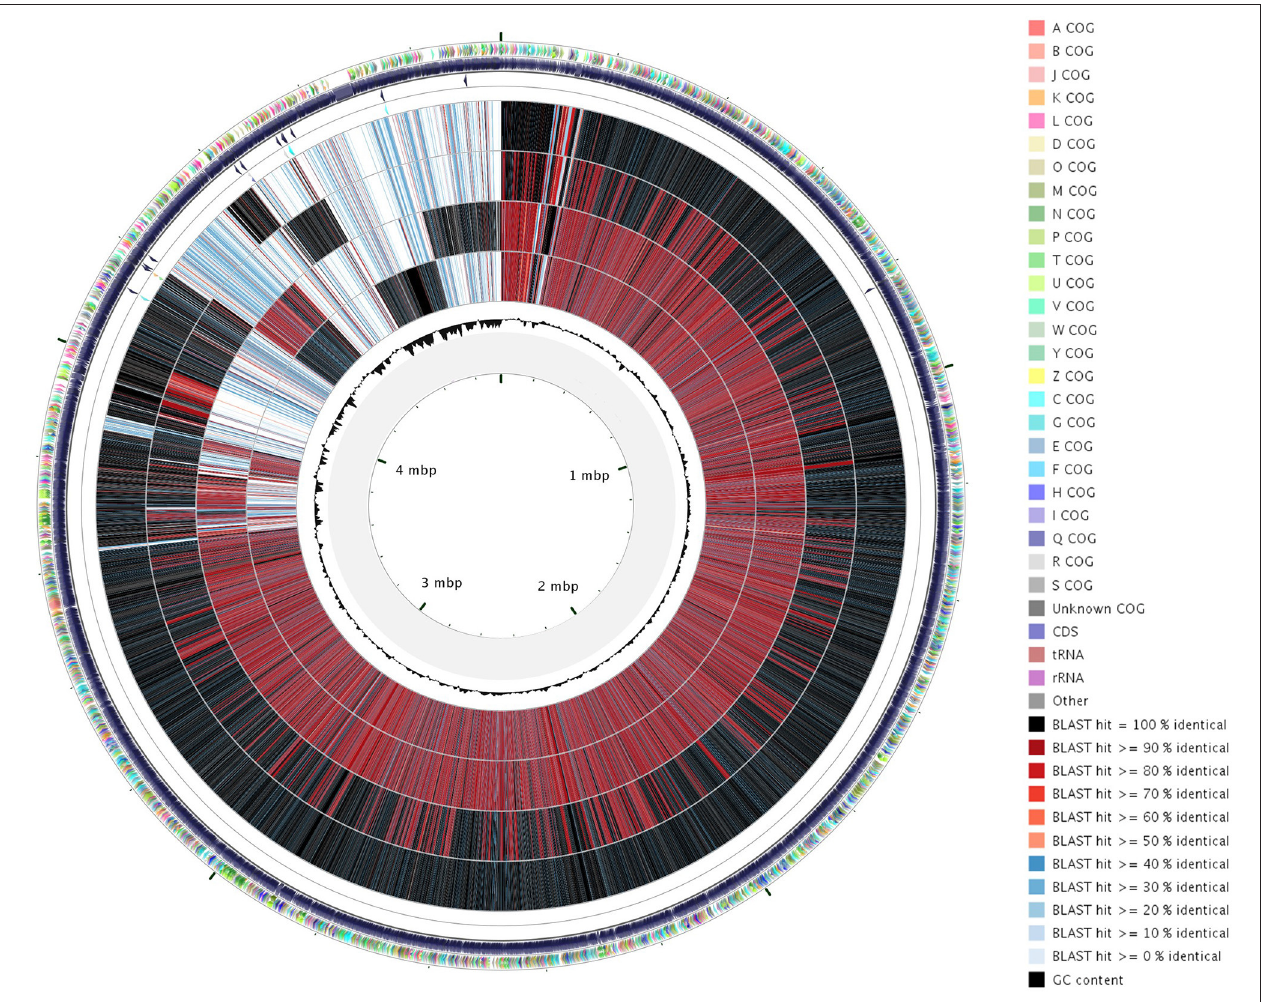
FIGURE 2 | Circular representation with CGView tool of the orthoMCL analysis of the four X. arboricola genomes. Genomic sequences were compared against each other and BLAST results were converted in a graphical map showing the entire sequences. From inside to outside, circle 1 indicates the G+C content, circles 2 to 5 represent CFBP 7634, CFBP 7651, CFBP 7179, CFBP 2528 locus-tags. The external circle shows COG classification of CDSs with different colors according to the legend. In circles 2 to 5, the color indicates the BLAST score (see